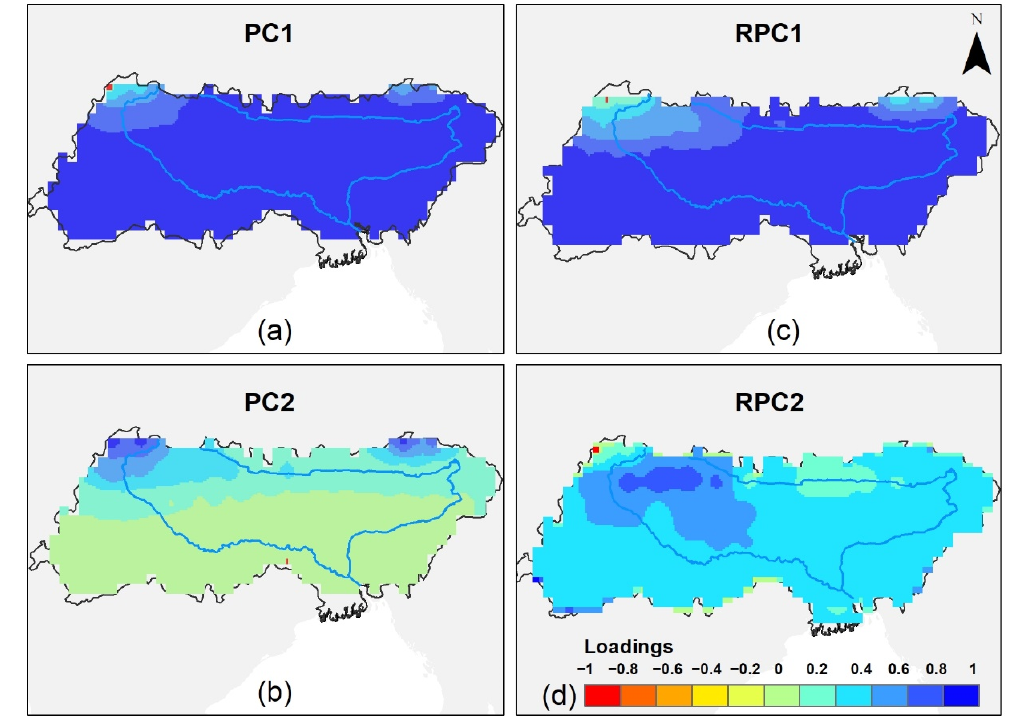
Figure 9. Loading patterns of two principal components of winter drought ( a , b ) and rotated loadings ( c , d ).